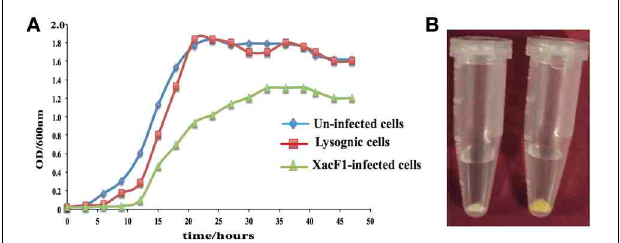
FIGURE 4 | (A) Effects of XacF1 infection on the growth of X. axonopodis pv. citri (MAFF301080). (B) Effects of XacF1 infection on EPS production. The pellet of uninfected Xac MAFF301080 cells (right) was yellow, while the pellet of XacF1-infected cells (left) was white, indicating a defect in xanthan